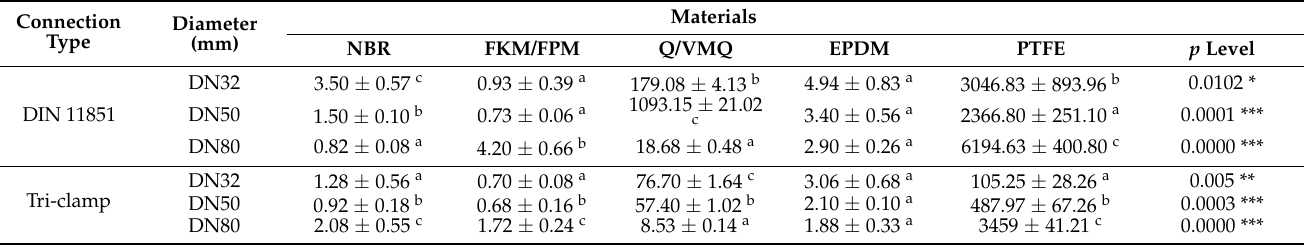
Table 2. Oxygen permeation ( × 10 − 3 hPa/h) of seals made of different elastomers in different connectors and diameters ( n =